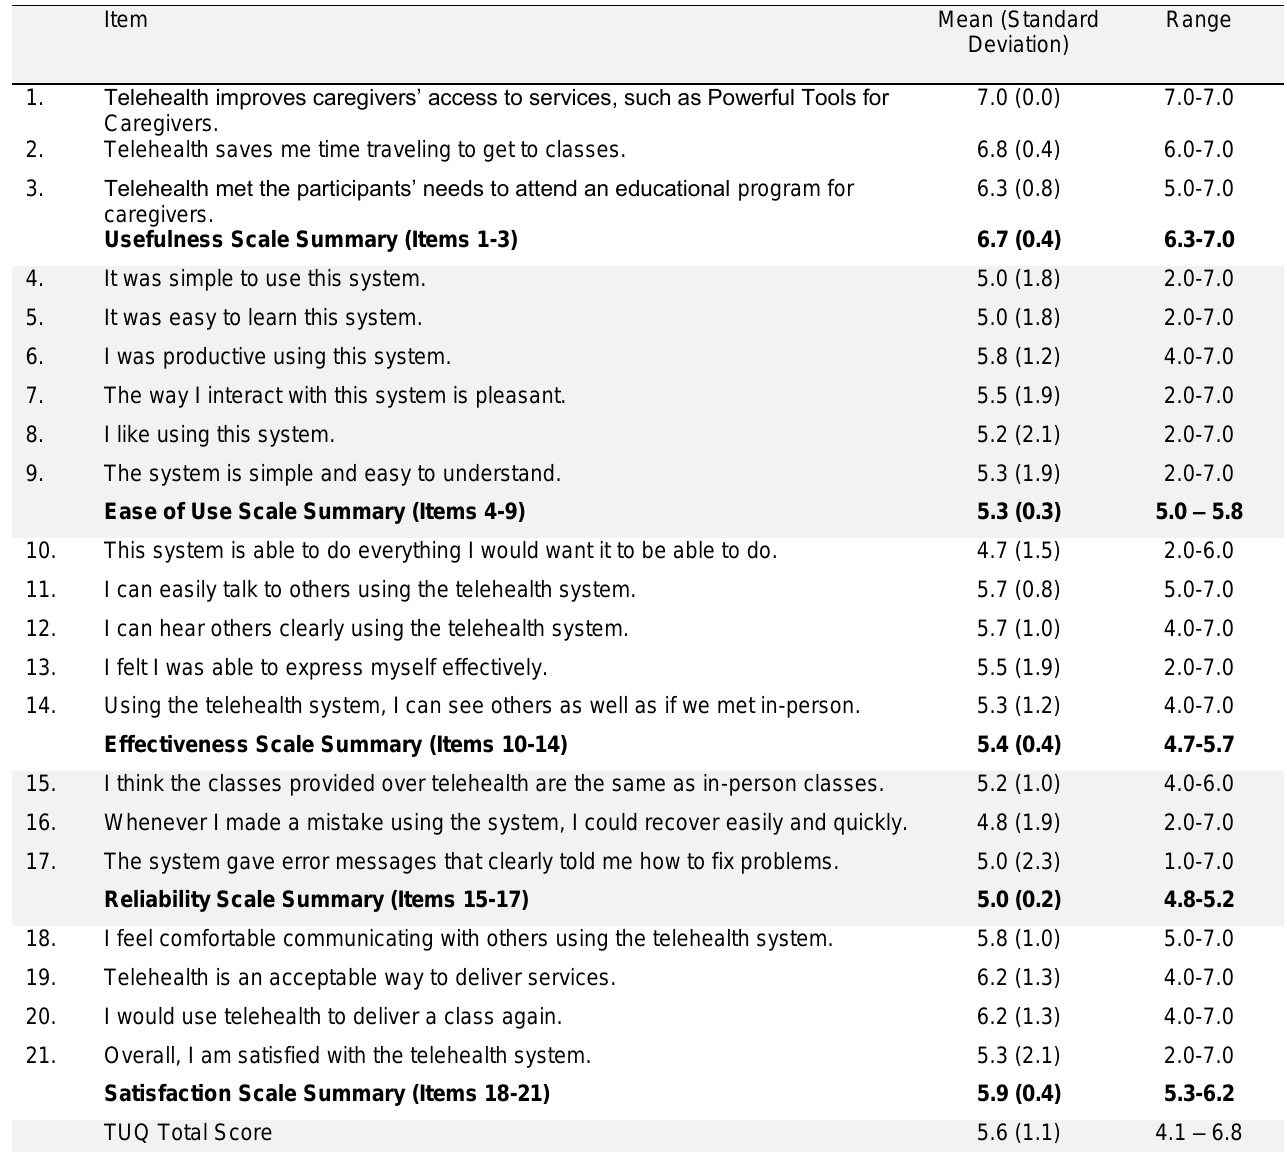
Table 2. Telehealth Usability Questionnaire (TUQ) Results (n=6)